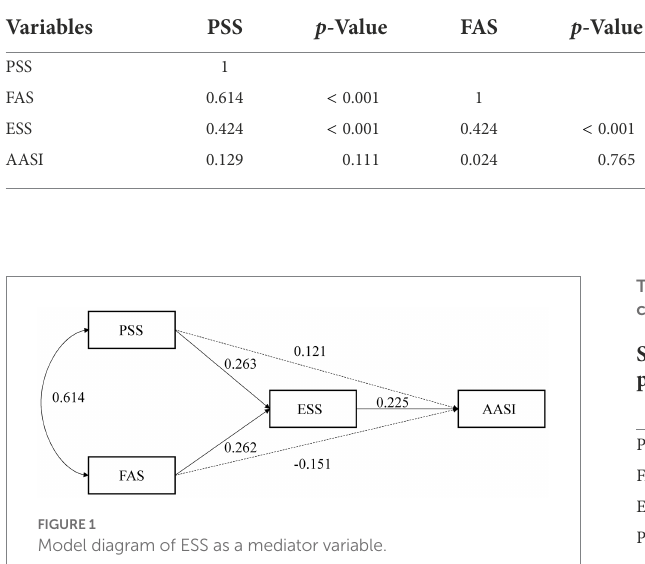
TABLE 3 Correlations and multi-collinearity values for PSS, FAS, ESS, and AASI.